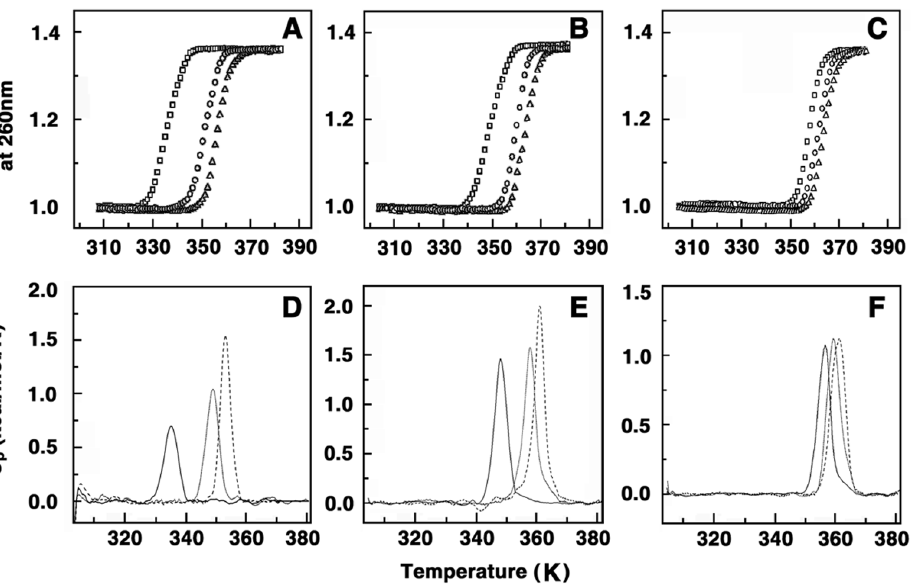
Figure 6. Melting profiles of DNA and DNA polyamine complexes. Optical melting profiles (upper panels) of (A) CP DNA ( % ), spermine-CP DNA( n ), spermidine-CP DNA (O), (B) EC DNA ( % ), spermine-EC DNA( n ), spermidine-EC DNA(O), (C) ML DNA ( % ), spermine-ML DNA( n ), spermidine- ML DNA(O). DSC melting profiles (lower panels) of (D) CP DNA (solid lines) (E) EC DNA (solid lines), (F) ML DNA (solid lines) and respective DNA– spermine complex (- - - -) and DNA-spermidine complex (….).